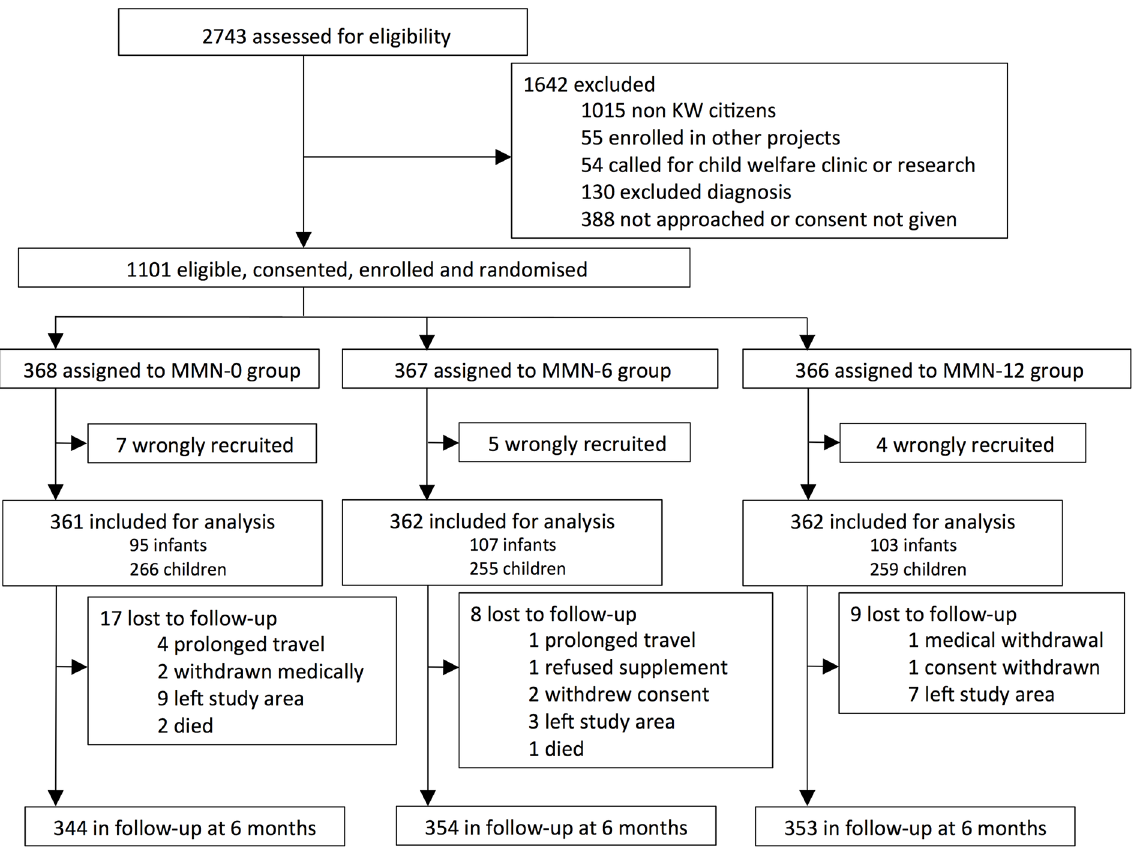
Fig 1. CONSORT flow chart of the trial. KW, Kiang West; MMN, multiplemicronutrients.